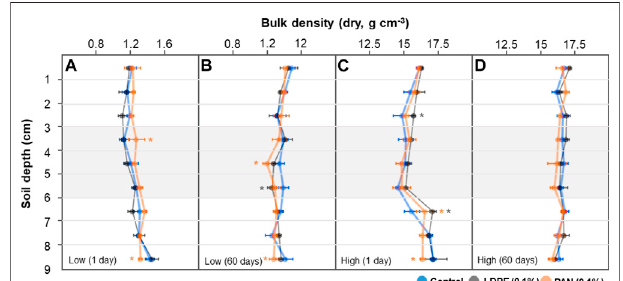
FIGURE 6 | Bulk density (dry, g cm − 3 ) at each soil depth (0 – 9 cm) of each soil column (control and microplastic-containing soil layer